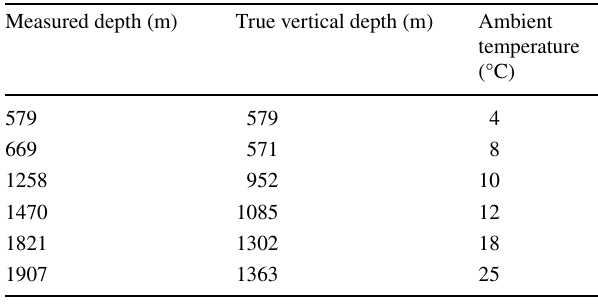
Fig. 5 Graph showing data from PVT matched with predicted data from Pedersen viscosity